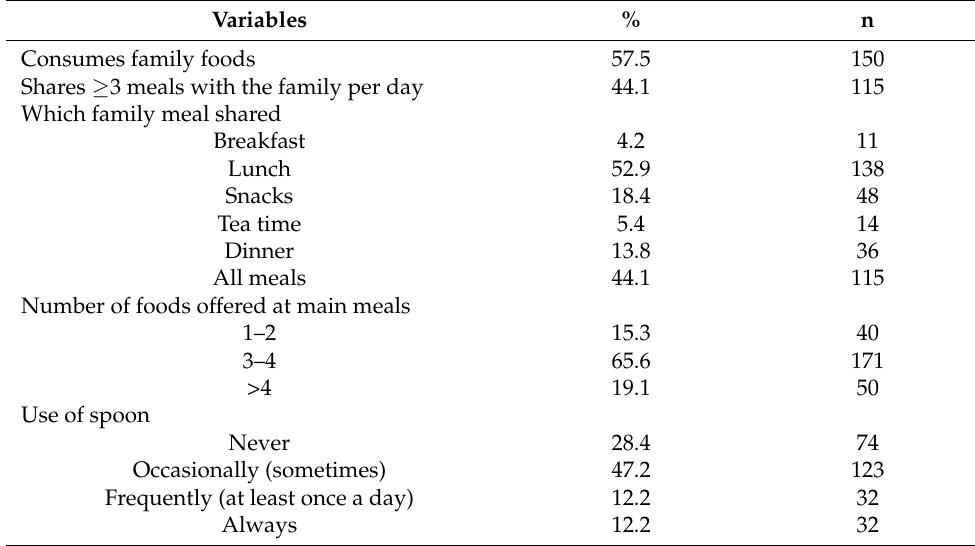
Table 2. Description of components of baby-led